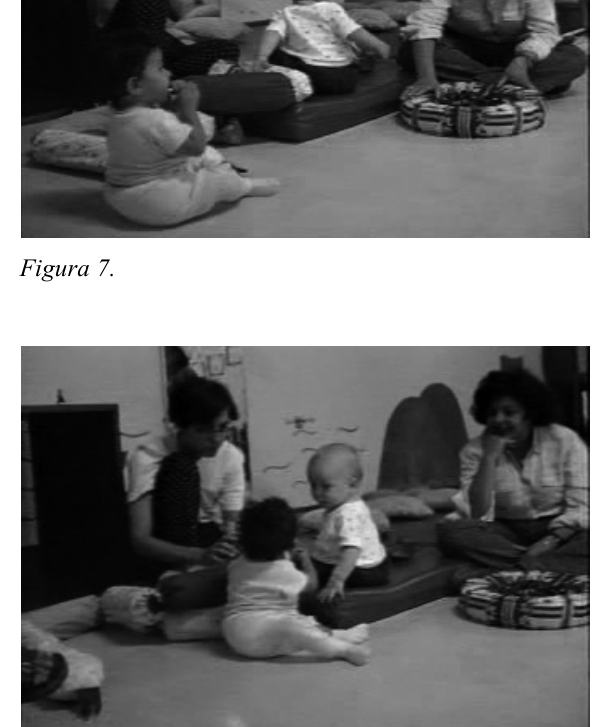
Esse episódio mostra-se bastante comum nos proces- sos interativos observados, em que, apesar de existir um grande número de objetos disponíveis, somente alguns figuram como atrativos, sendo que outros não despertam interesse. Repetidamente, as crianças têm a atenção e